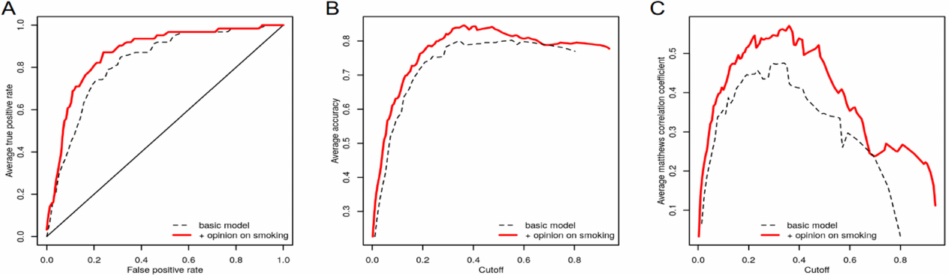
Figure 4. Comparison of performance measures of complete vs. basic predictive model for smoking behavior in foster care teenagers. ( A ) Receiver operating characteristic (ROC) curve. ( B ) Average accuracy depending on cut-off. ( C ) Average Matthews correlation coefficient depending on cut-off.